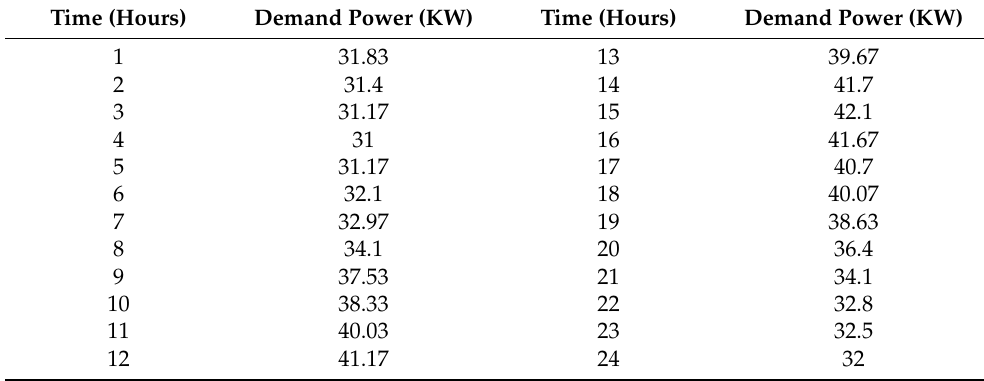
Table 3. Total initial demand.